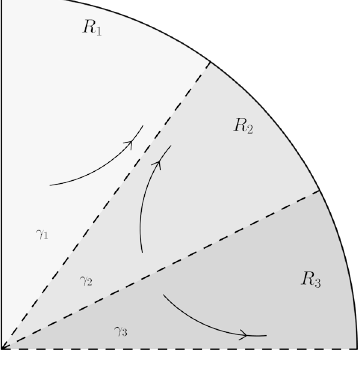
Fig. 1. Phase portrait of the Ricci flow on SO ( 2 n + 1 )/( U ( k ) × SO ( 2 n + 1 )) and on Sp ( n )/( U ( m ) × Sp ( k ))